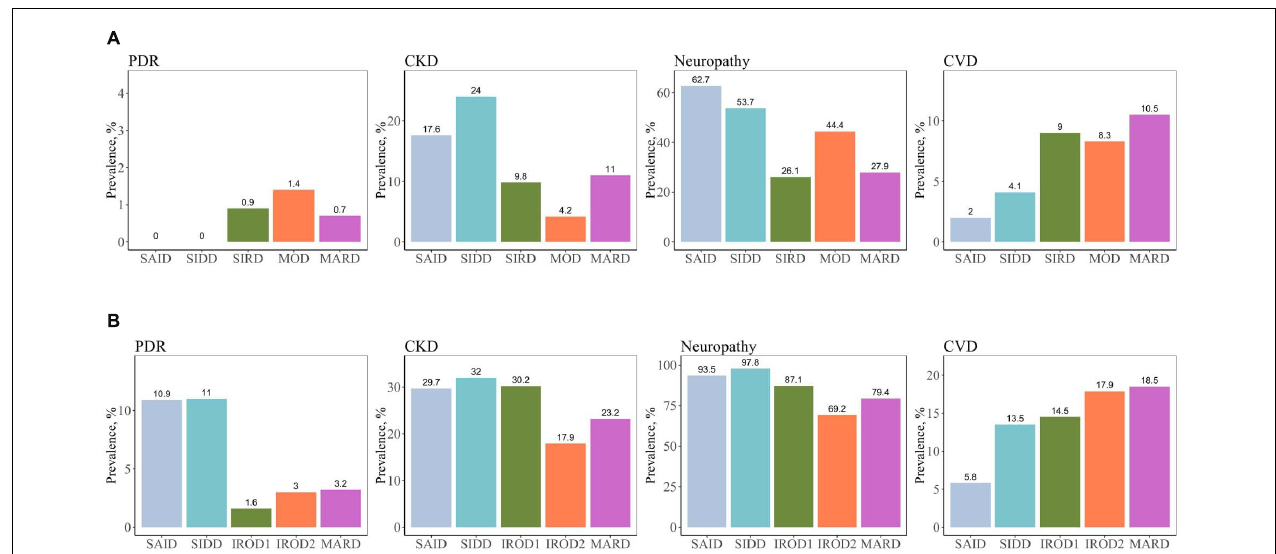
FIGURE 3 | Prevalence of macro- and microvascular complications in different clusters of adult patients with the new-onset and long-term diabetes. (A) Individuals with new-onset adult diabetes with less than 3 years of disease duration ( n = 887). (B) Individuals with long-term adult diabetes with more than 3 years of disease duration ( n = 1,253). PDR, proliferative diabetic retinopathy; CKD, chronic kidney disease; CVD, cardiovascular disease. TABLE 2 | Risk of macro- and microvascular complications in different clusters in long-term adult diabetes relative to MARD. Complications SAID